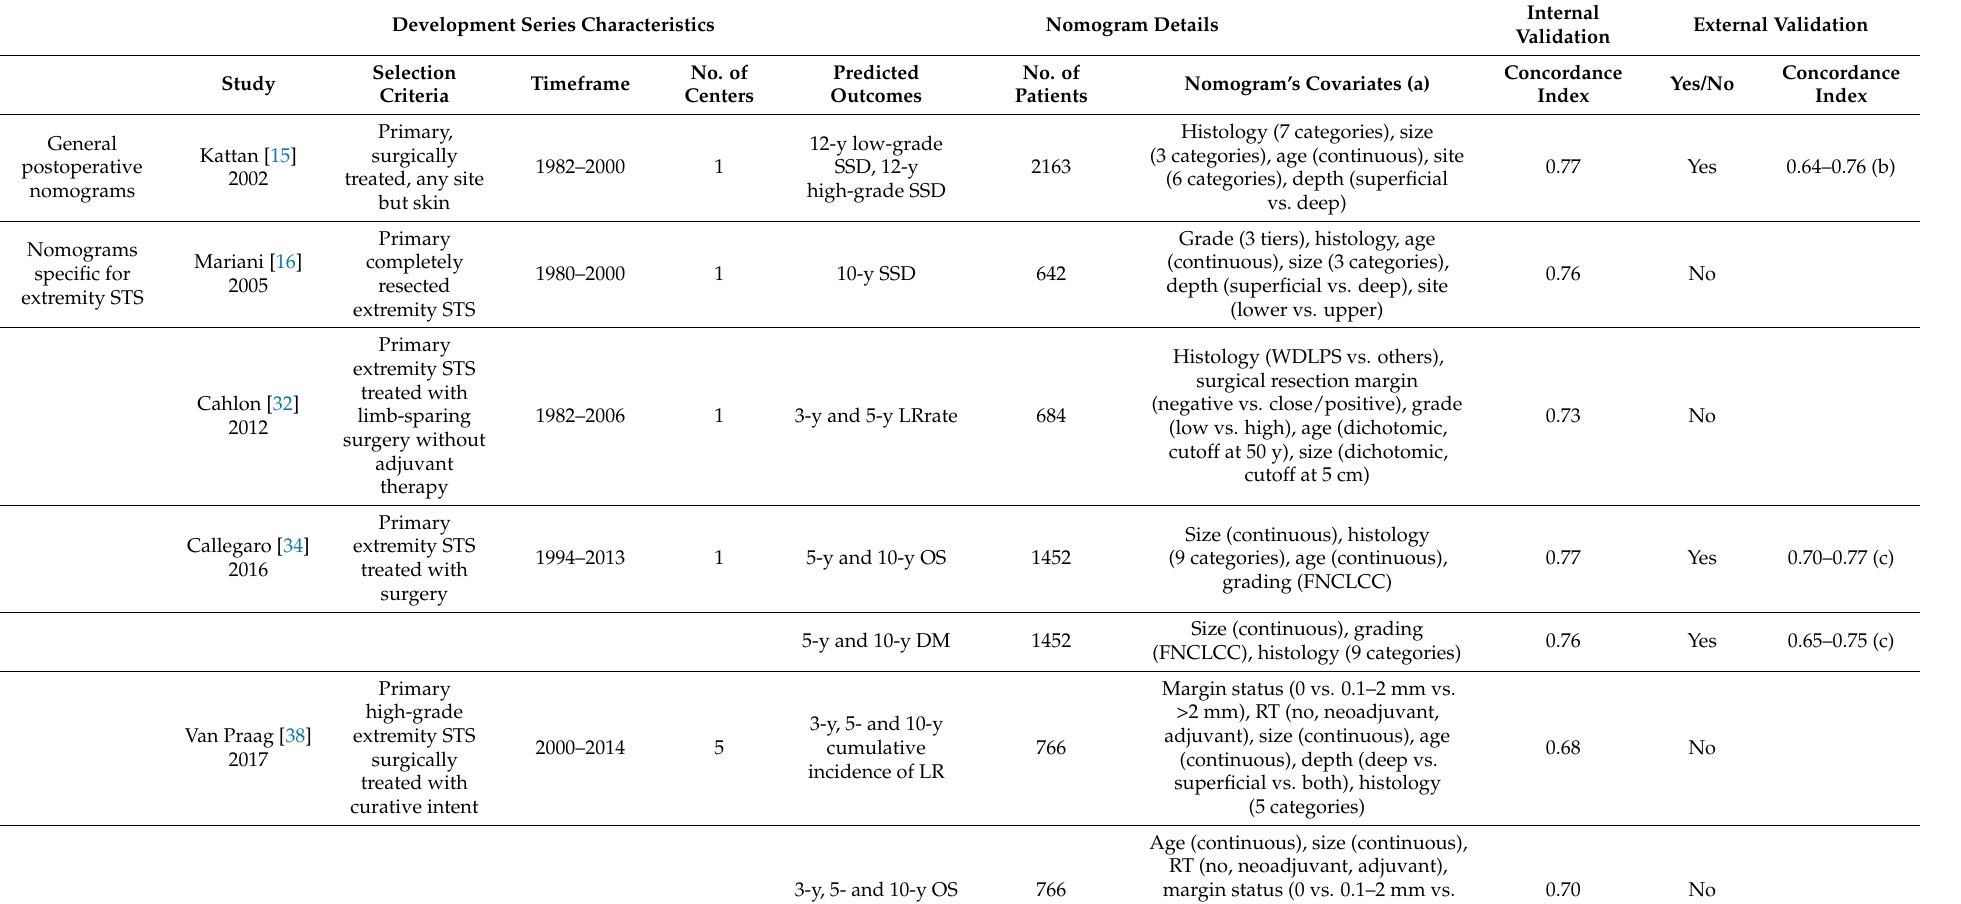
Table 1. General and extremity-specific nomograms for patients with